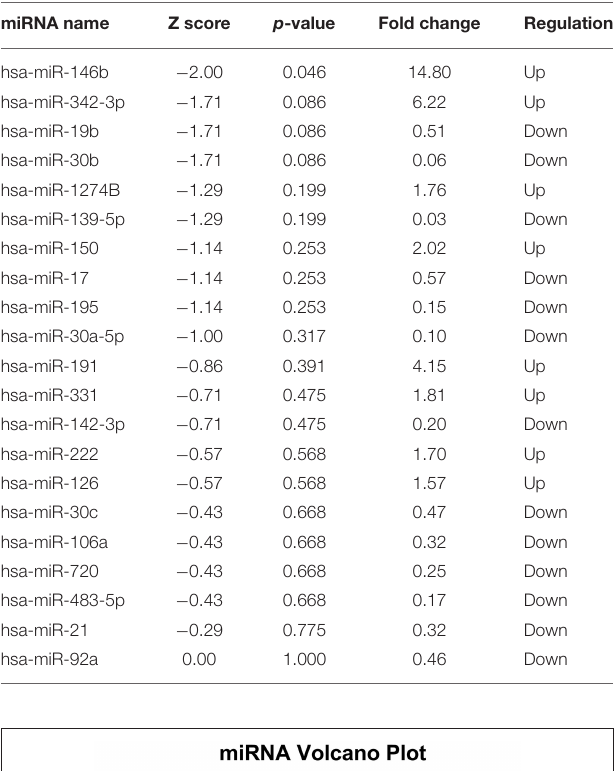
TABLE 4 | MicroRNA up-regulated or down-regulated in MM with or without CVAEs as determined by Open Array fold change < 0.5 and ≥ 1.5.